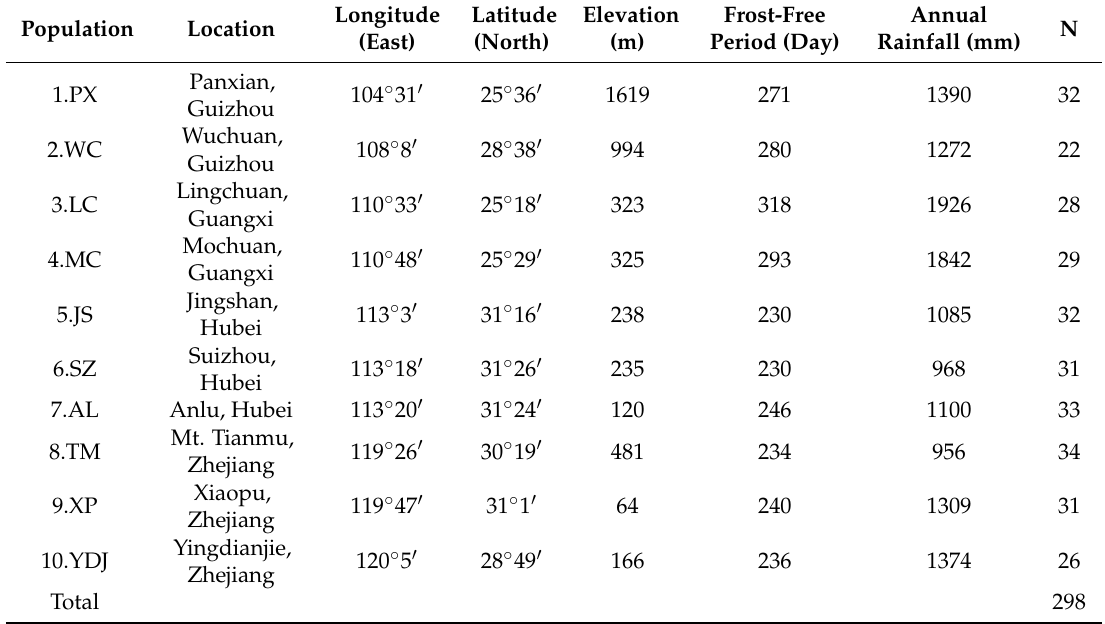
Table 1. Location, and some characteristics (longitude, latitude, elevation, frost-free period, annual rainfall and sample size (N)) of 10 populations of G. biloba